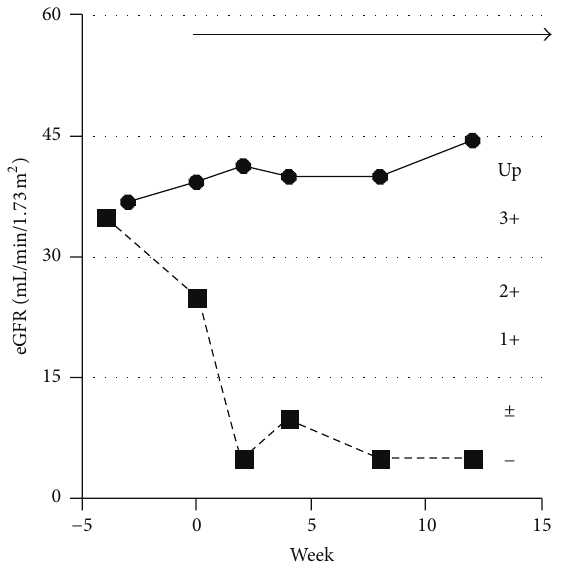
Figure 2: eGFR and proteinuria around the initiation of eculizumab. Obvious proteinuria (closed squares, up), and quickly disappearing proteinuria by initiation of eculizumab treatment (arrow). Closed circles denote